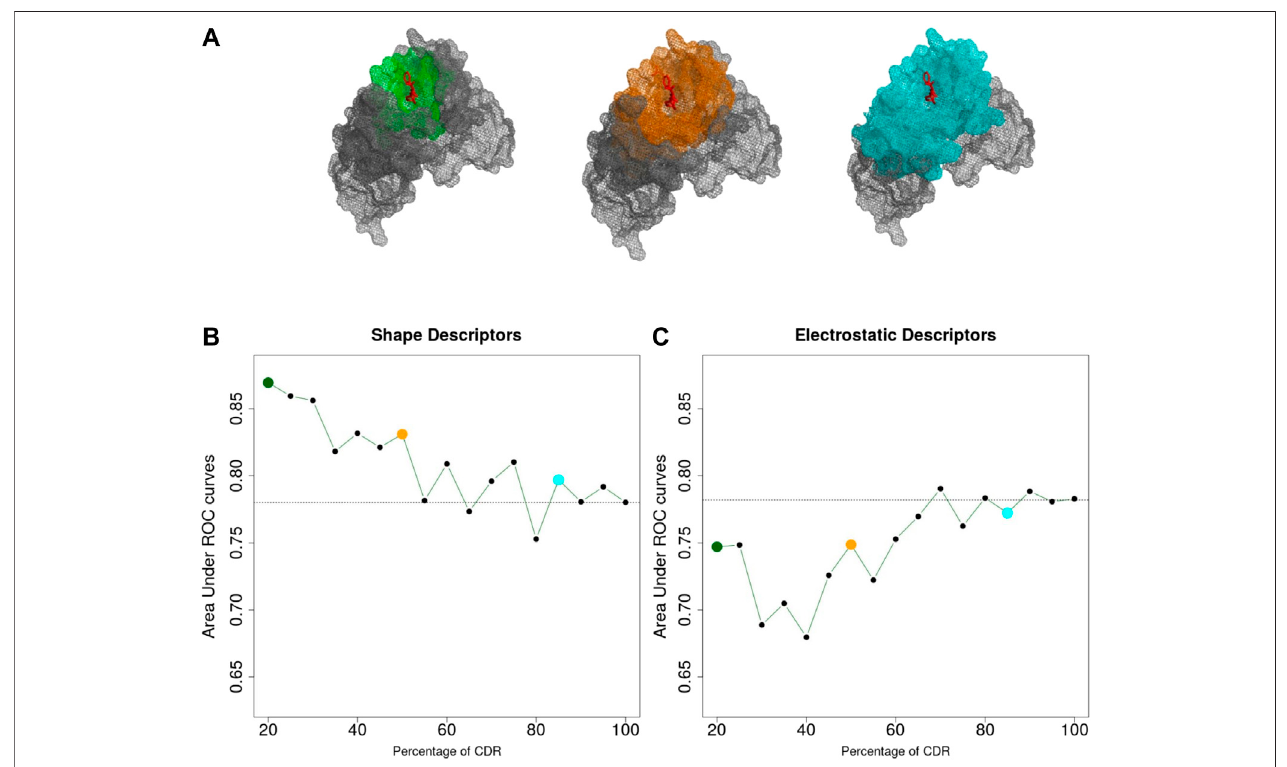
FIGURE 3 | (A) Portion of the CDR surface used for classi fi cation. (B,C) Area Under the ROC Curve achieved considering different portions of the CDR, based on shape (B) and electrostatics (C) 3DZD descriptors. Dashed lines indicate the performances obtained considering the entire CDR surface (AUC (cid:1) 0.78 for both